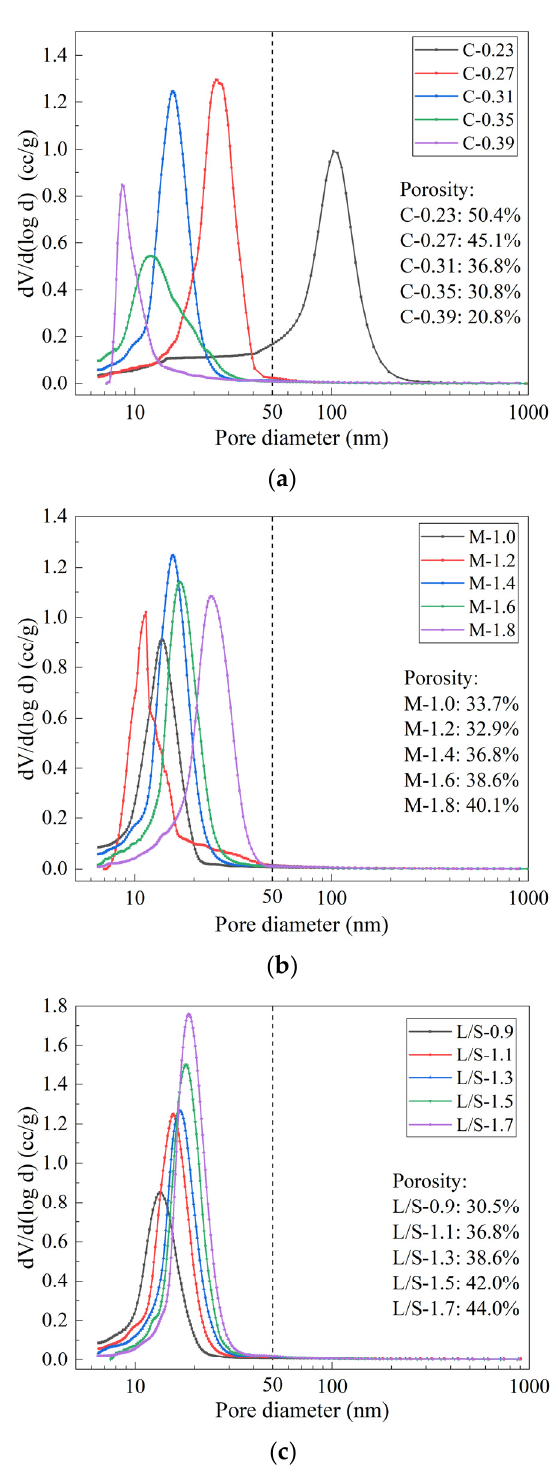
Figure 5. Pore distribution and porosity of MK/GGBFS-blended geopolymer pastes synthesized with varying concentrations ( a ), moduli ( b ), and L/S ratio ( c ).